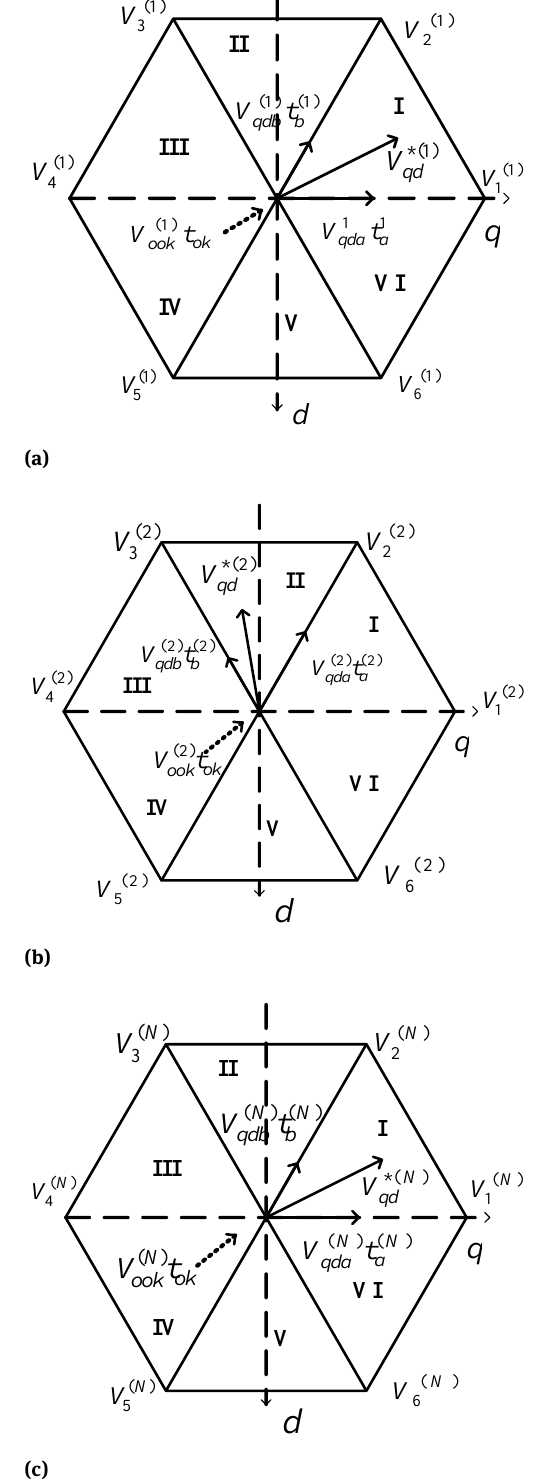
Figure 3: Decoupled space vector hexagons of 12 -switch converter for (a) Inv 1 , (b) Inv 2 , and (c) Inv 3